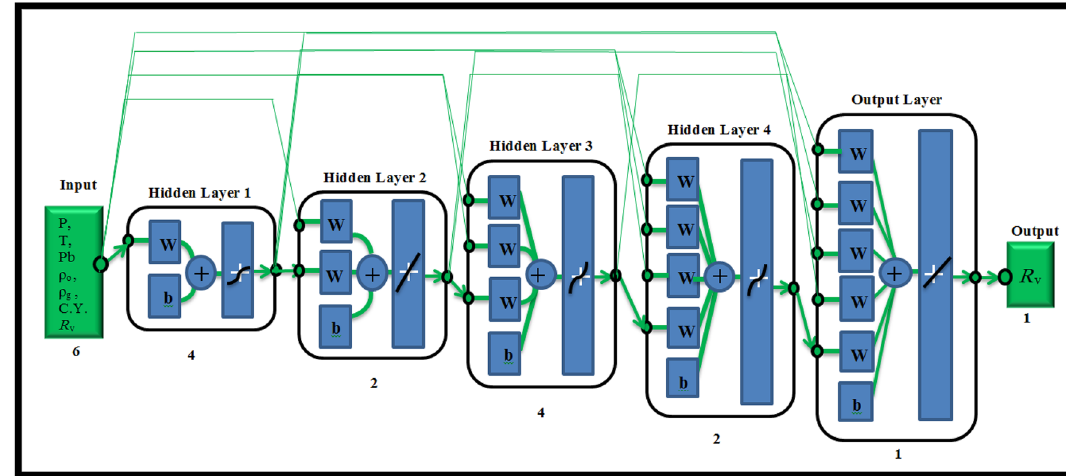
Fig. 2 Trainable cascade-forward backpropagation, Type